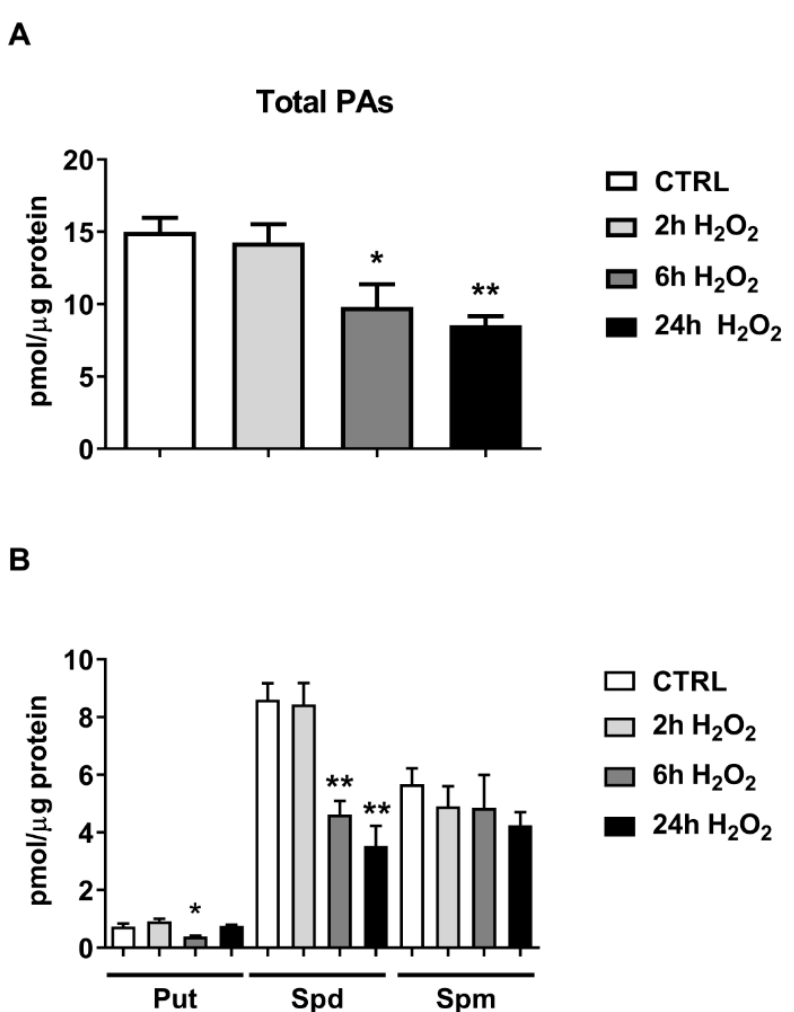
Figure 4. Effect of H 2 O 2 on C2C12 myoblast polyamine content. C2C12 myoblasts were treated with H 2 O 2 0.3 mM for different times (2–24 h). ( A ) Evaluation of total polyamines content; ( B ) Evaluation of Put, Spd and Spm levels. Data presented are the mean ± SEM of three experiments, each performed in triplicate. One ‐ way ANOVA was performed followed by Bonferroni’s multiple comparisons test * p < 0.05; ** p < 0.01 vs. CTRL.